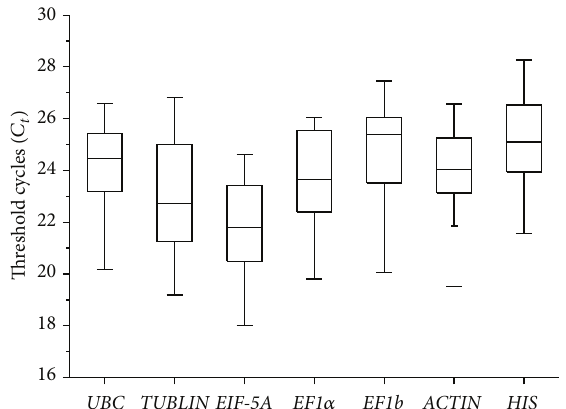
Figure 1: Absolute cycle threshold values ( 𝐶 𝑡 ) for seven reference genes. Boxes indicate the 25th/75th percentiles, the line marks the median, squares represent the means, and whiskers indicate the ranges for total